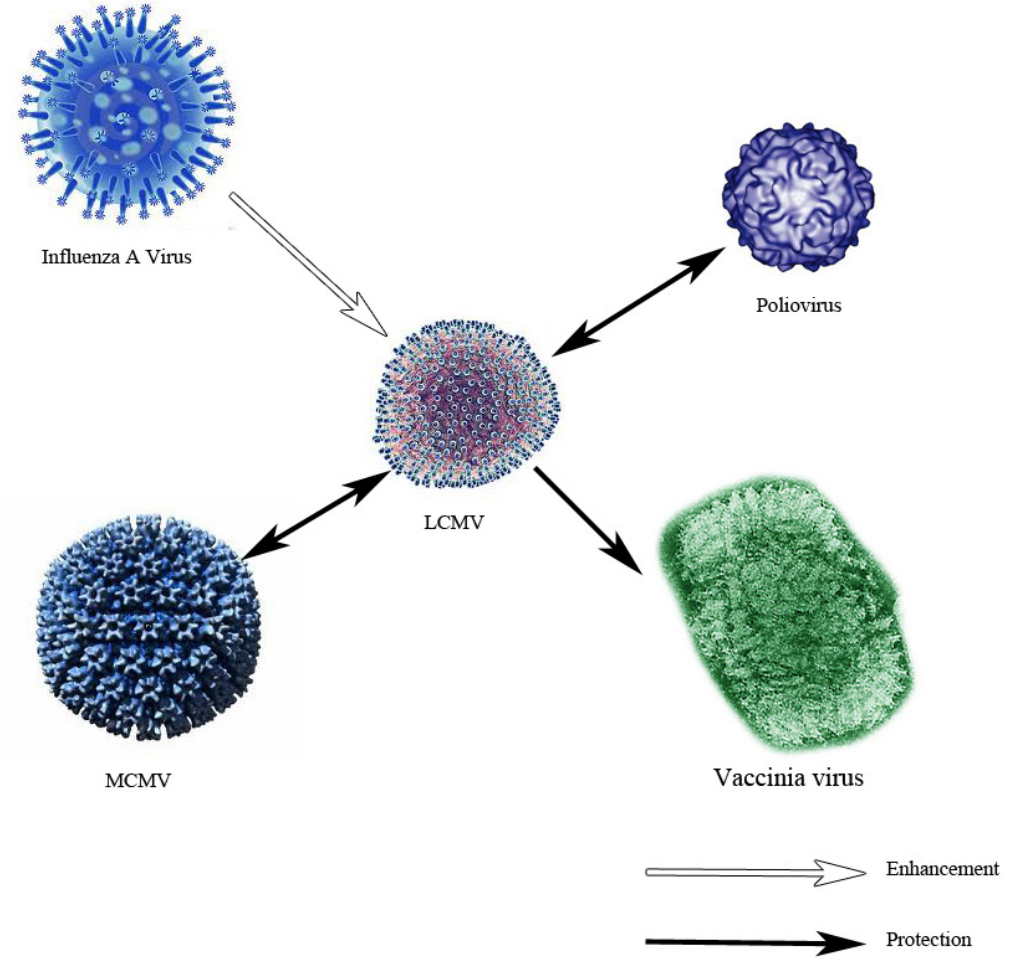
immunity between LCMV and other viruses. These experiments were performed using C57BL/6 mice. The black filled arrows indicate a protective effect between the first infection (base of arrow) and the challenge infection (head of arrow). In some cases this protection from heterologous immunity is bi-directional as shown. On the contrary, the unfilled arrow depicts an enhancement of disease when infection of influenza A precedes LCMV